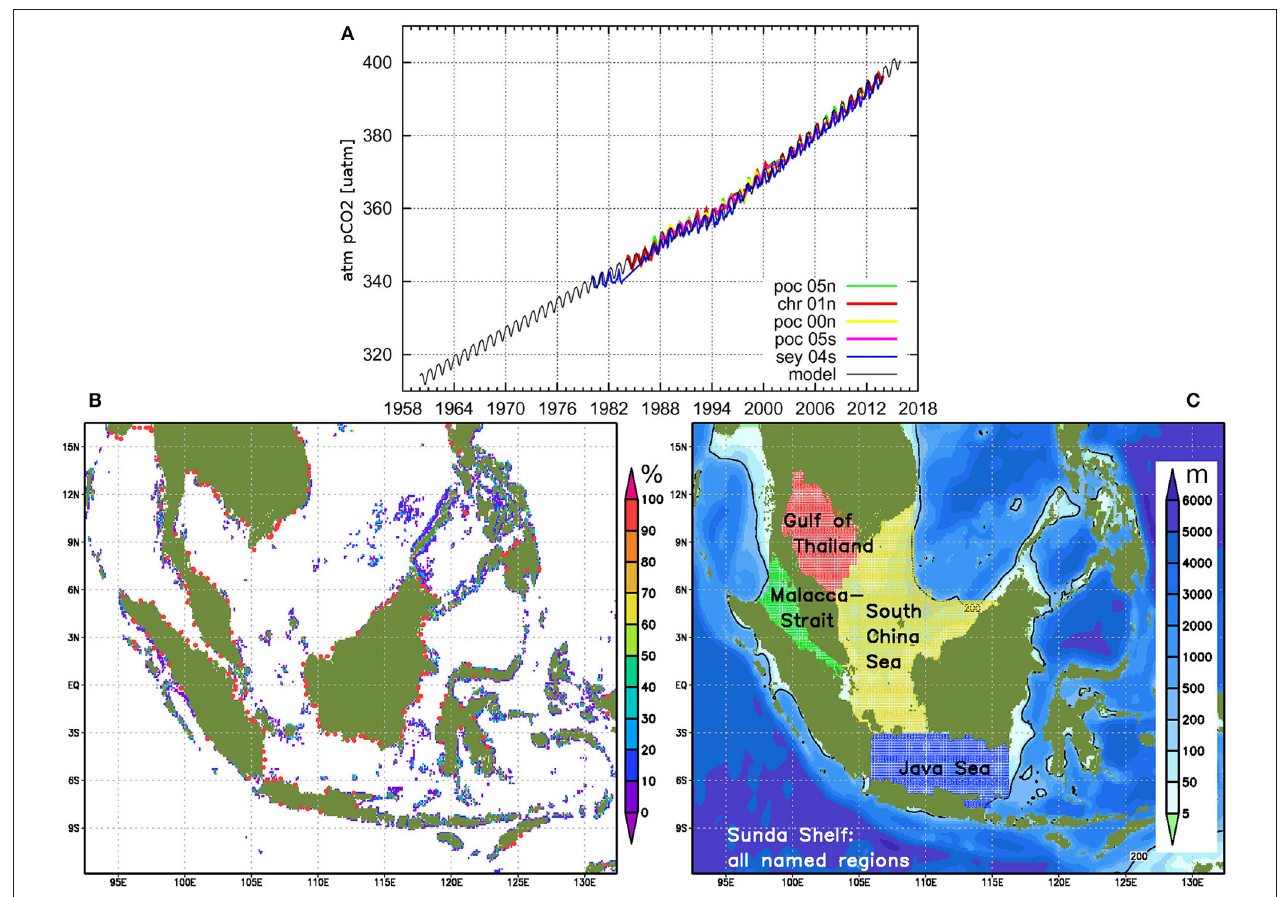
FIGURE 2 | (A) Atmospheric CO 2 content in our simulations (black curve). Colored curves show measured data between 5 ◦ N und 5 ◦ S in the Pacific Ocean (poc) and the Indian Ocean (chr = Christmas Islands, sey = Seychelles). Measured data kindly made available by Dlugokencky et al. (2017). (B) Distribution of warm water corals in our domain in percent of the area of grid cells with coral reef presence. (C) Regions (colored shadings) referred to in this article for different spatial averages: Gulf of Thailand (red), Malacca Strait (green), Java Sea (blue). These three regions plus the southern South China Sea (yellow) make up our inner Sunda Shelf